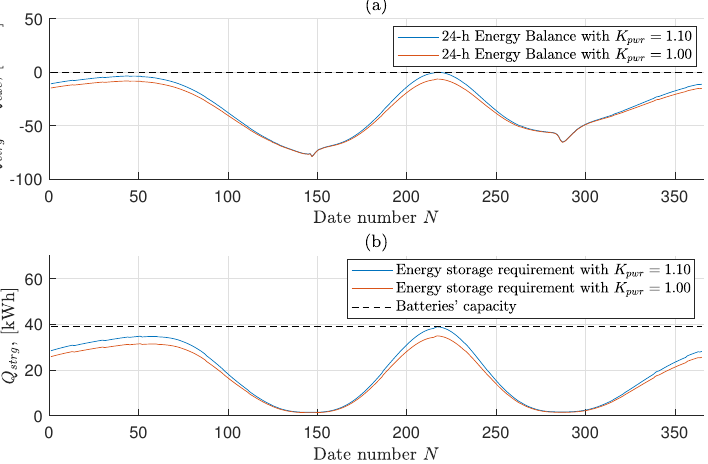
Figure 13. Energy balance evaluation ( a ) and energy storage requirement ( b ) for operation throughout the year at 18.06 km altitude above Port-au-Prince,